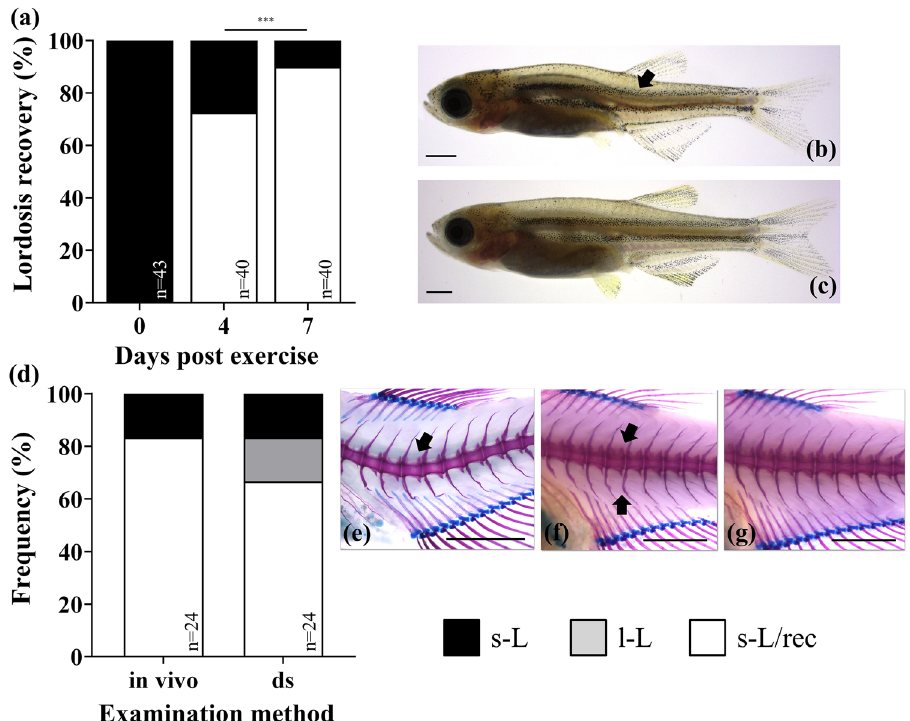
Figure 1. Recovery frequency of the external morphology of the severe lordotic individuals at 4 and 7 dpe ( a – c ) and valorization of the scoring methodology by means of double staining ( d – g ) at the end of the recovery period (7 dpe). ( b , c ) Representative case of the transition of a juvenile from a typical lordotic (s-L) to a recovered (s-L/rec) external morphology respectively. ( e – g ) Representative cases of the internal bone structure of a severe lordotic (s-L), a light lordotic (l-L) and a recovered (s-L/rec) individual after double staining (ds) respectively. Scale bars equal to 1 mm. n, individual number assessed. Asterisks indicate significant differences ( p <